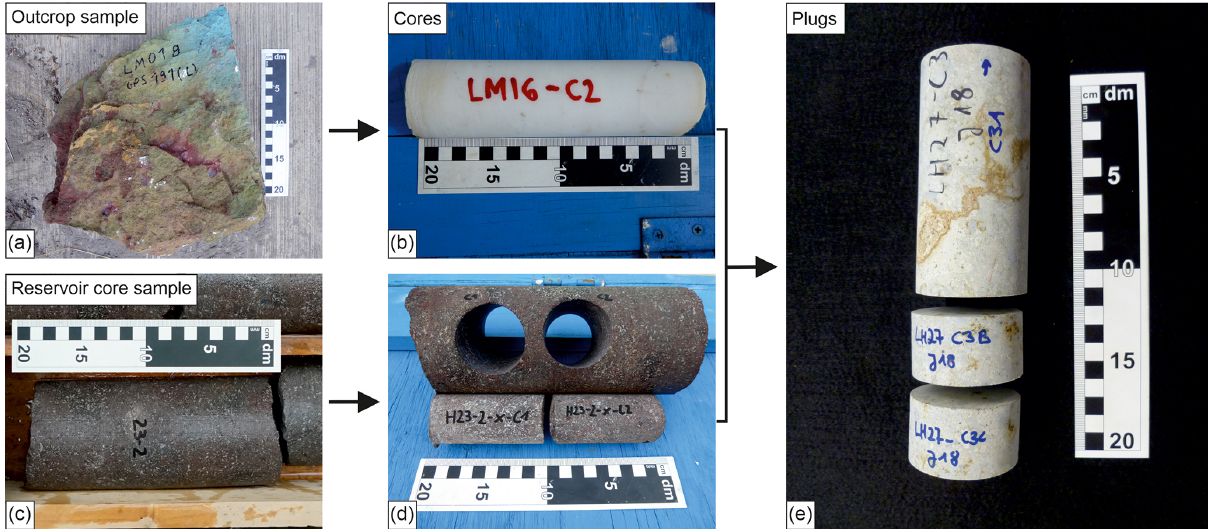
Figure 4. Overview of the different preparation steps and sample labeling. Cores ( b , various diameters; d , 40mm in diameter) drilled from outcrop samples (a) and reservoir core samples (c) and subsequently cut into plugs (e) to meet the individual requirements of the measurement devices. The plugs were labeled with capital letters. Table 1. Overview of the field campaigns and related